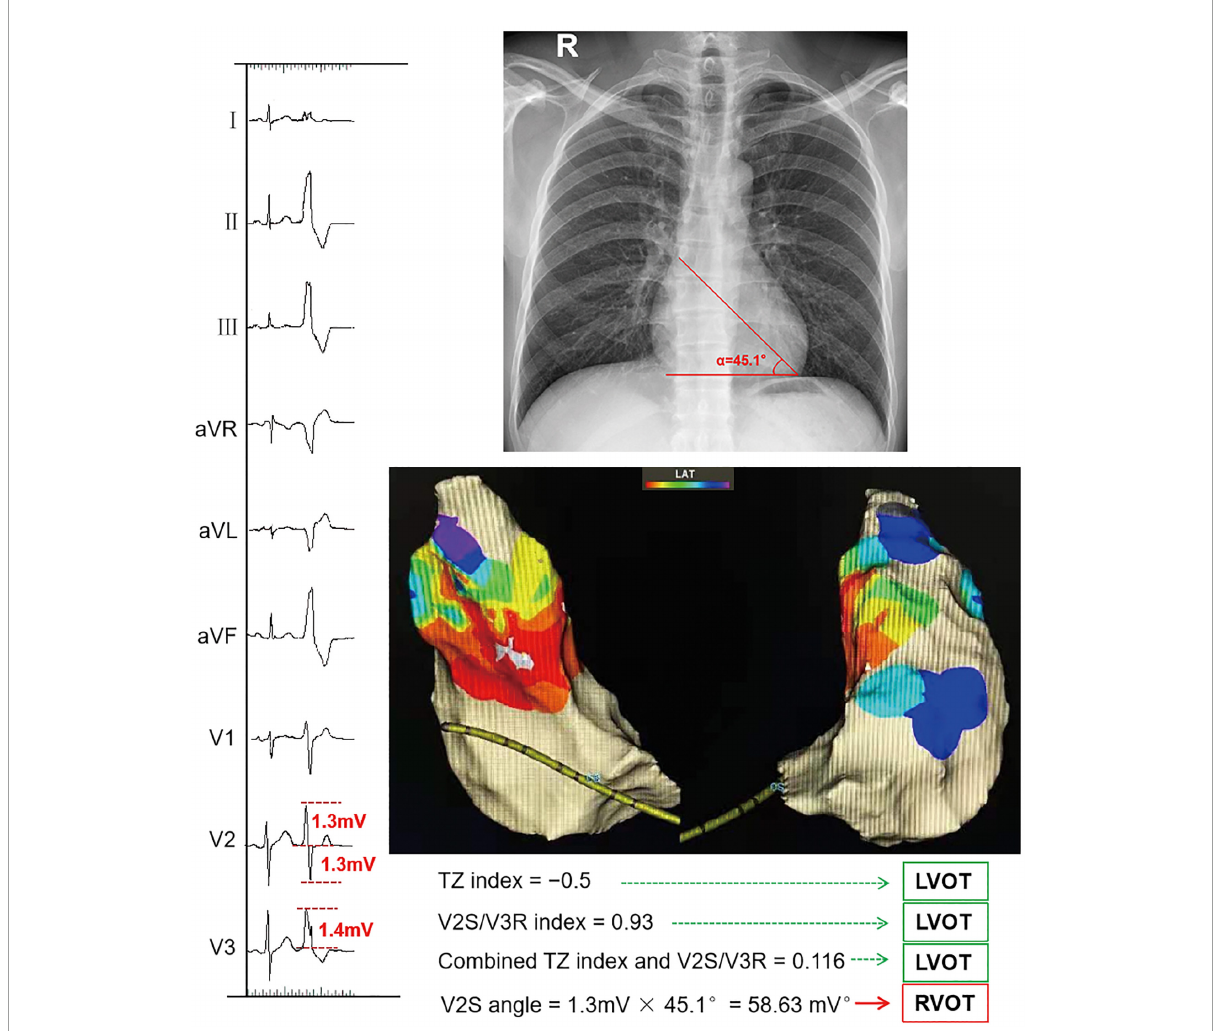
FIGURE1 Example of calculating the V2S angle and several ECG algorithms. The TZ index was –0.5 according to the following formula: TZ score of OTVA minus TZ score of sinus beat (2–2.5 = –0.5). The V2S/V3R index was calculated with the following formula: V2S/V3R = 1.3 mV/1.4 mV = 0.93. The combined TZ index and V2S/V3R were calculated with the formula Y = –1.15 × (TZ)–0.494 × (V2S/V3R) = –1.15 × (–0.5)–0.494 × 0.93 = 0.116. These indexes indicate that this OTVA had a left ventricular outflow tract (LVOT) origin, though it was successfully ablated in the septal aspect of the right ventricular outflow tract (RVOT). The measurements of the V2S angle during the OTVAs are as follows: the S-wave amplitude in lead V2 is 1.3 mV. The angle ( α ) between the cardiac long-axis anatomically and the horizontal plane on chest radiography is 45.1 ◦ . The V2S angle was calculated with the following formula: (V2S × α ) = 1.3 mv × 45.1 ◦ = 58.63 (mV ◦ ). The V2S angle was verified as